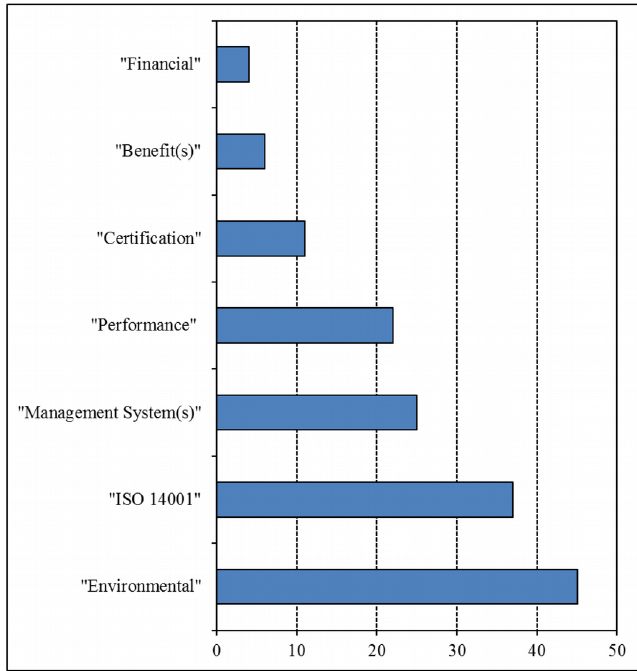
Figure 10. ISO 14001 EMSC articles keywords (authors